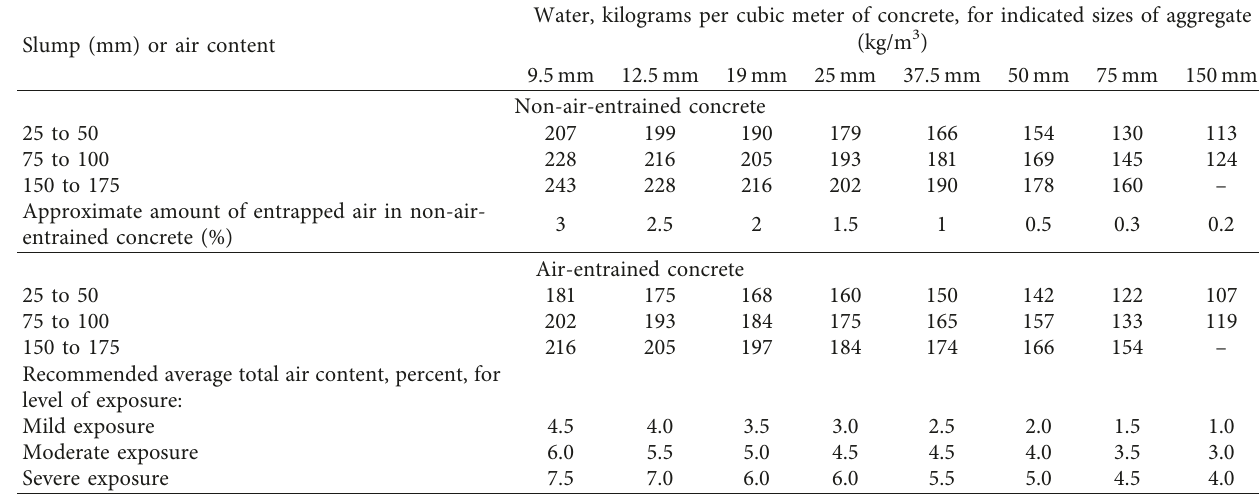
Recommended average total air content, percent, for level of exposure: